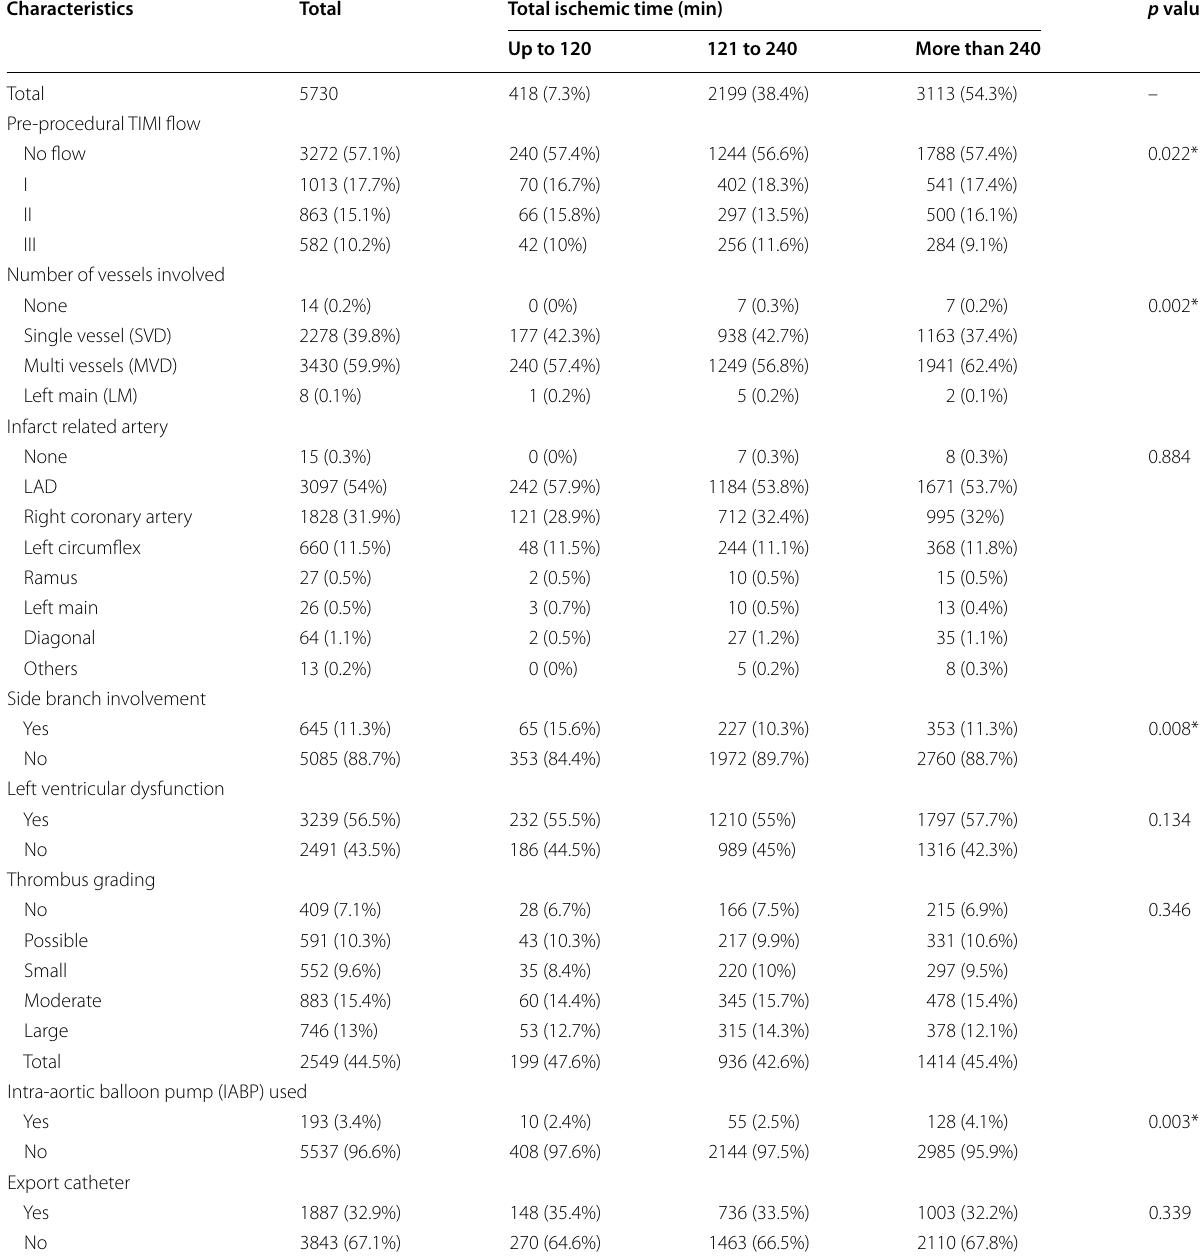
LAD left anterior descending artery, TIMI thrombolysis in myocardial infarction *Significant at